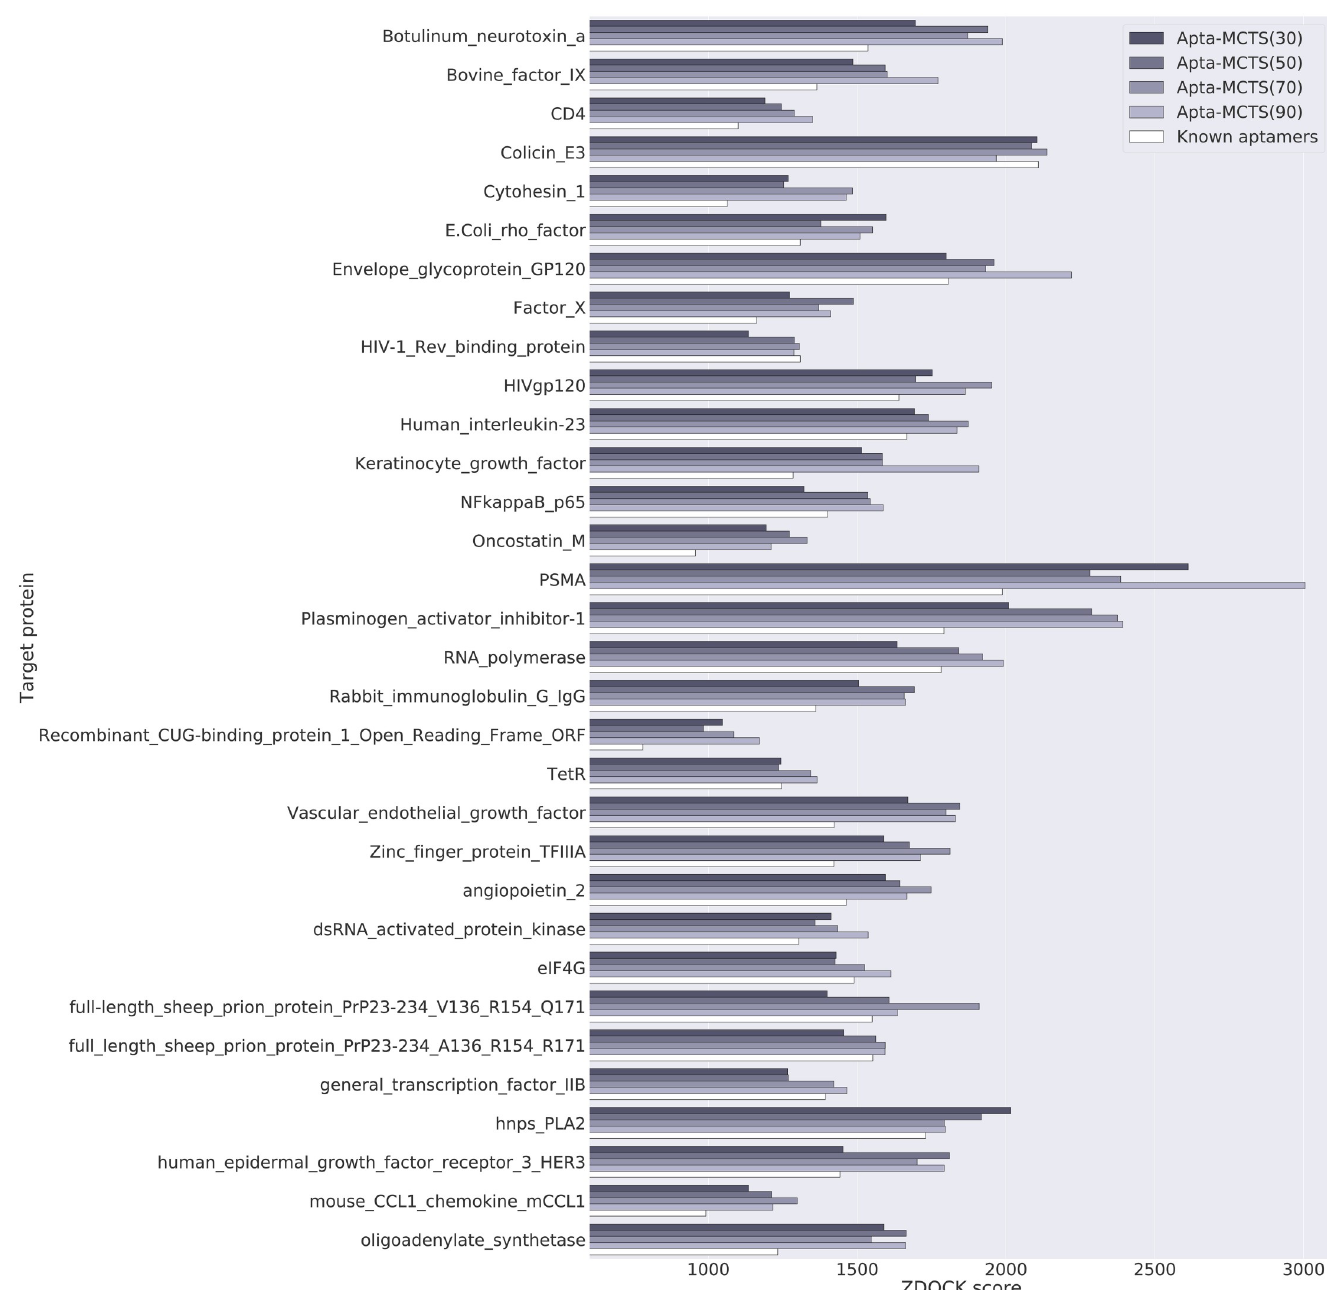
Fig 6. Docking scores for aptamers of various lengths with 32 target proteins in the test dataset. In general, our model generated better aptamers than the known aptamers in the test dataset. The docking scores of our candidate aptamers are reflected by the grey bars, while the known aptamers by the white bars. For most proteins, aptamers with 70 bases and 90 bases (the 3 rd and 4 th bars in each protein) showed the highest docking score (Note that all the results in detail are available in S5 Table).